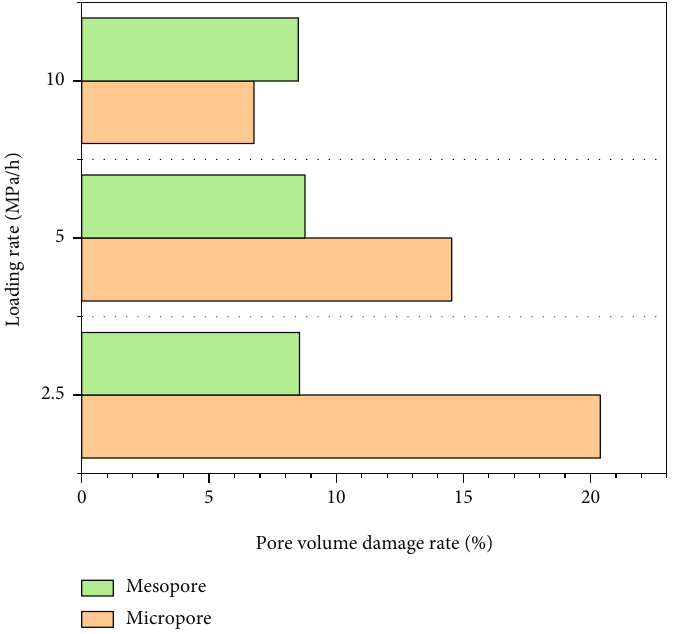
Figure 9: Pore volume damage rate at di ff erent loading rates.